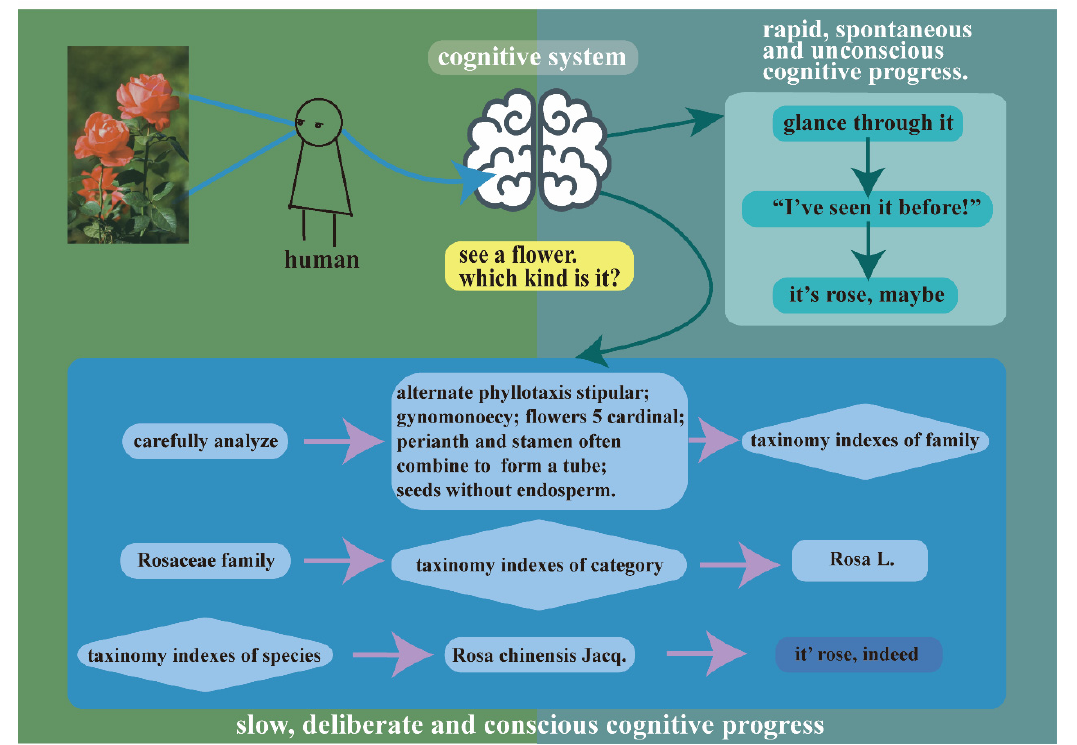
Figure 3. Human cognitive system operation when recognizing flower.